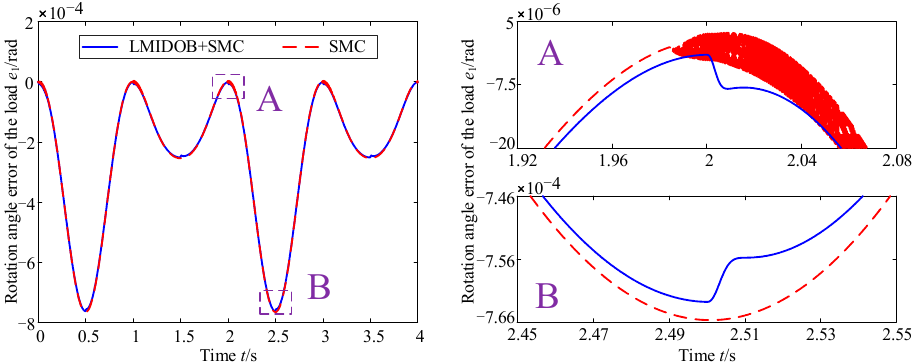
Figure 9. Position tracking performance of control strategy at the variable stiffness condition.